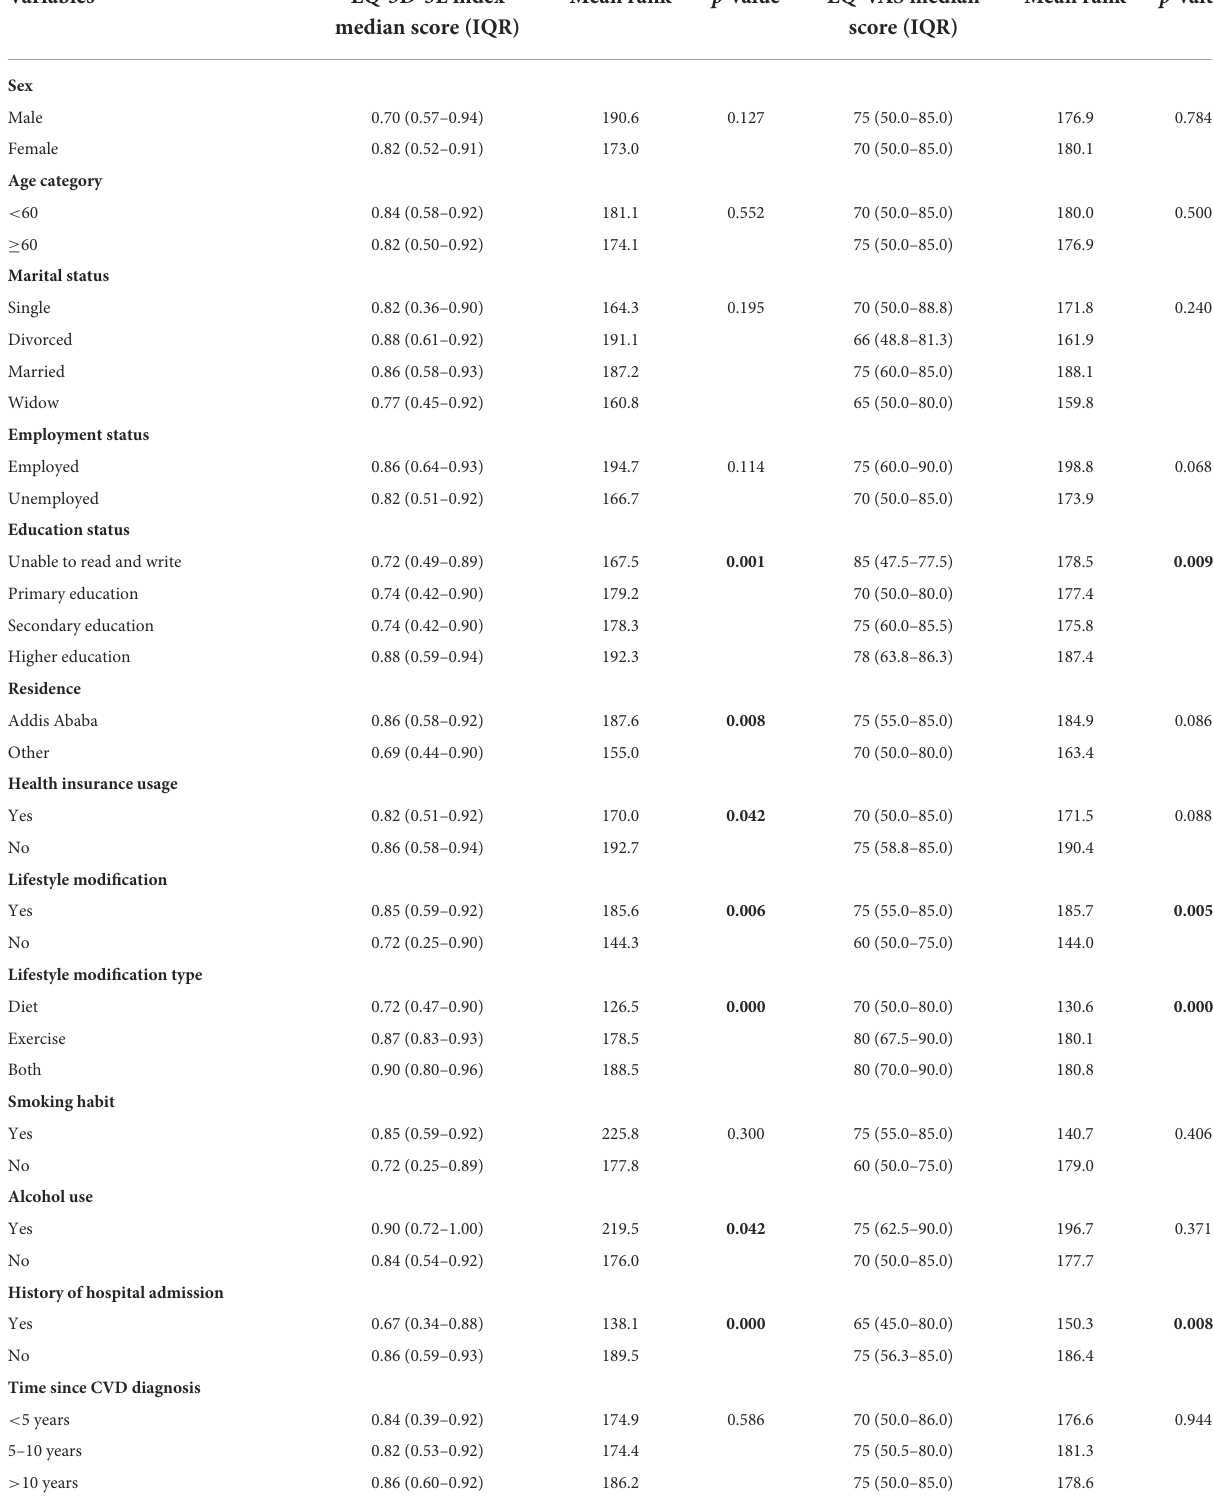
TABLE 3 Median (IQR) differences of EQ-5D-5L utility and EQ-VAS scores with patient